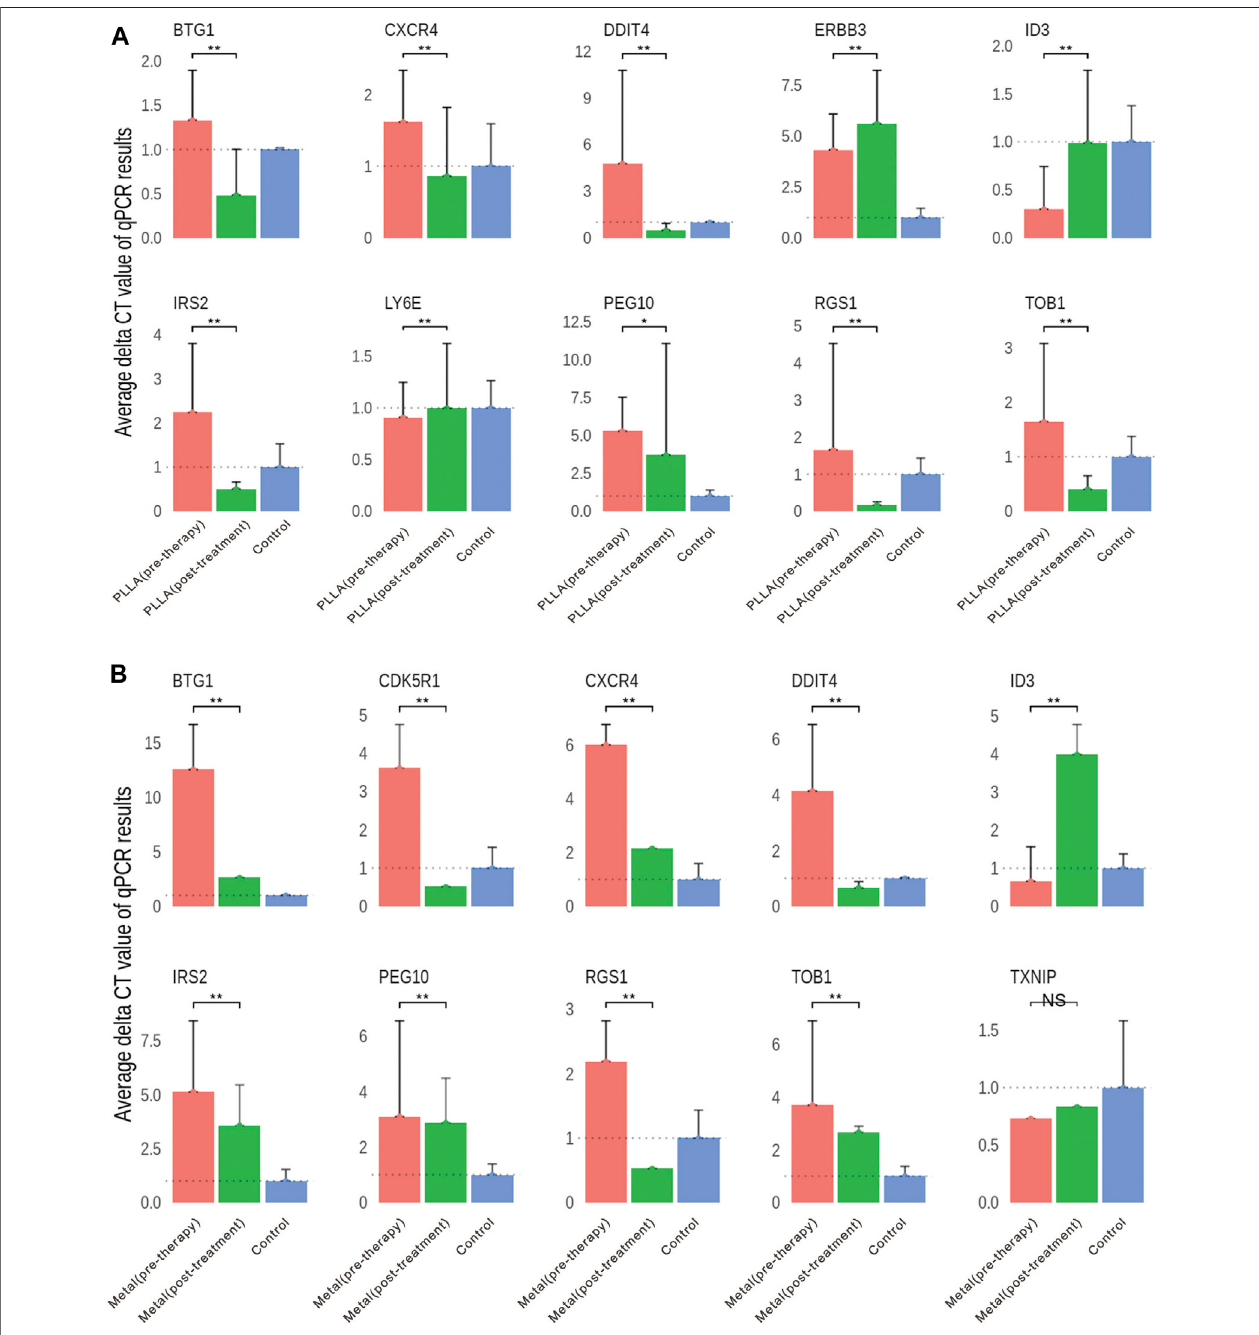
FIGURE 5 | Validation of DEGs by qRT-PCR. (A) Gene expression differences in the PLLA device pre-therapy group and post-treatment group. (B) Gene expression differences in the metal device pre-therapy group and post-treatment group. NS, no signi fi cant; * p < 0.05, ** p < 0.01.